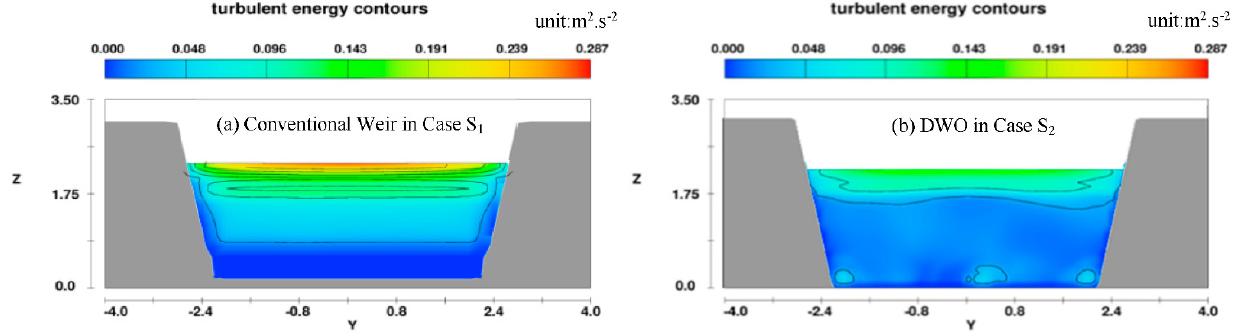
Figure 15. Turbulent energy contours of the cross − section ( X/L =0.21, upstream) for the conventional